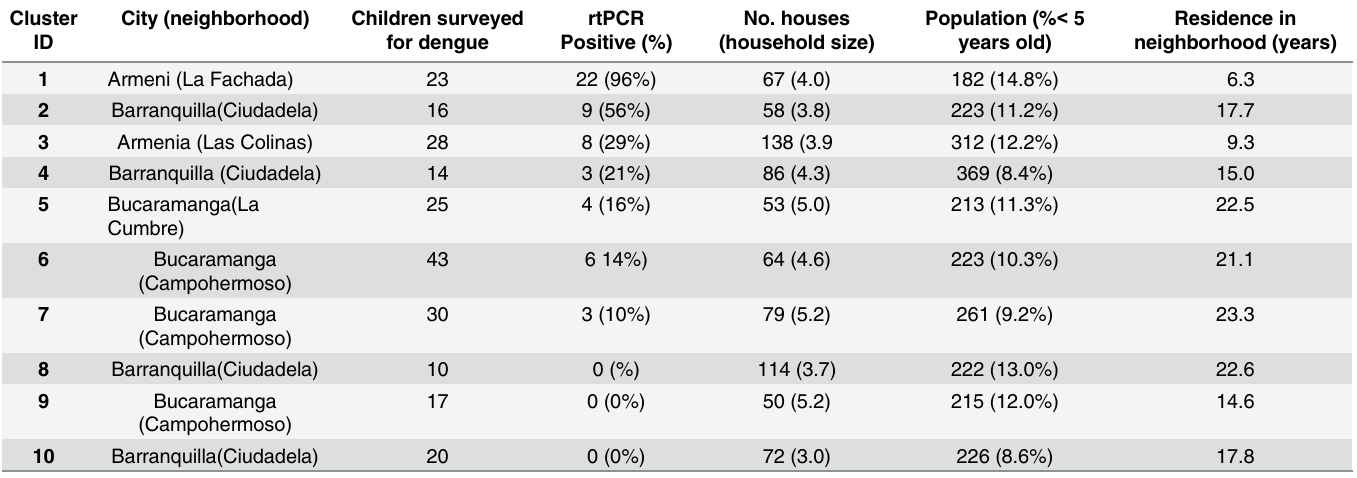
Table 1. Frequency of dengue viremia in children and demographic features of each of 10 2-block study patches in highly endemic neighborhoods of Armenia, Barranquilla and Bucaramanga, Colombia. Additional information on A . aegypti habitats and visitors to homes provided in Table A in S1 File. Cluster City ID